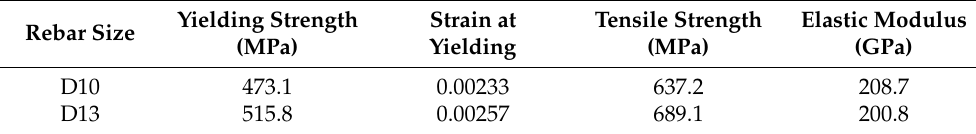
Table 4. Mechanical Properties of Rebar Used in